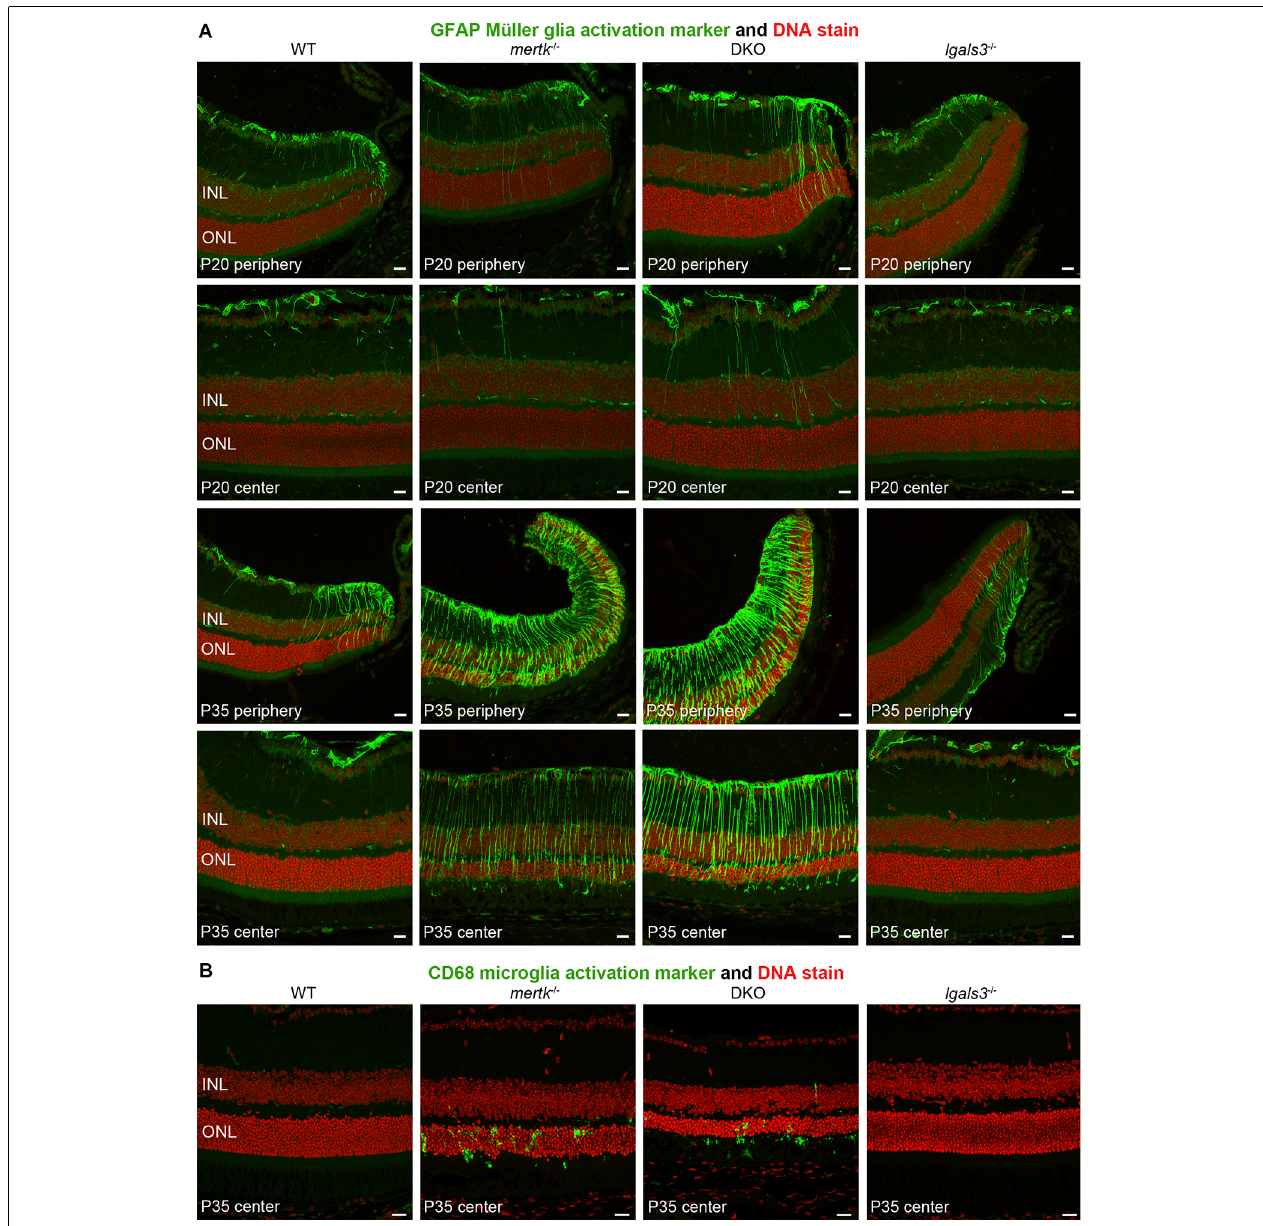
FIGURE 4 | Galectin-3 deficiency in mice lacking MERTK causes enhanced GFAP expression indicative of Müller glia activation. Tissues from age-matched WT, mertk -/- , DKO, and lgals3 -/- mice (ages indicated in panels) were processed side-by-side for sectioning and immunofluorescence microscopy of GFAP (A) and CD68 (B) . (A) Images show more pronounced peripheral GFAP (green) at P20 and more pronounced central GFAP in DKO as compared to mertk -/- at P35. WT and lgals3 -/- showed modest GFAP labeling at both ages as expected. (B) At P35, mertk -/- and DKO retina but not WT and lgals3 -/- retina showed CD68 labeling in the outer retina, with no apparent difference between mertk -/- and DKO. In all fields, nuclei counterstain is shown in red. Inner nuclear layer (INL) and outer nuclear layer (ONL) are indicated to show tissue orientation. Representative images are shown of four eyes from four different mice analyzed per staining, genotype, and age. All scale bars: 40 µ